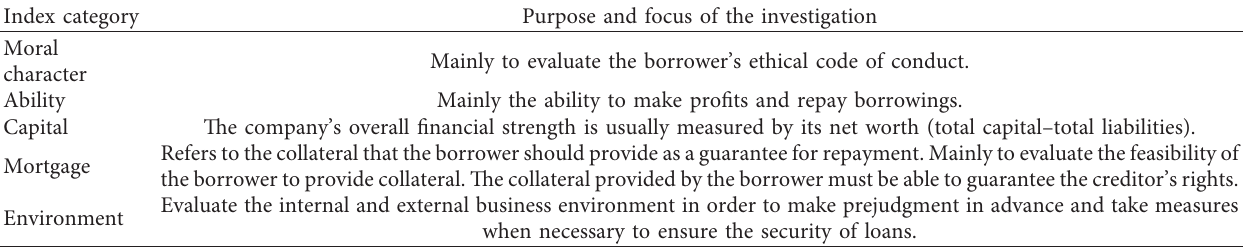
Table 1: The main indexes of the pre-evaluation of foreign bank credit institutions. Index category Purpose and focus of the